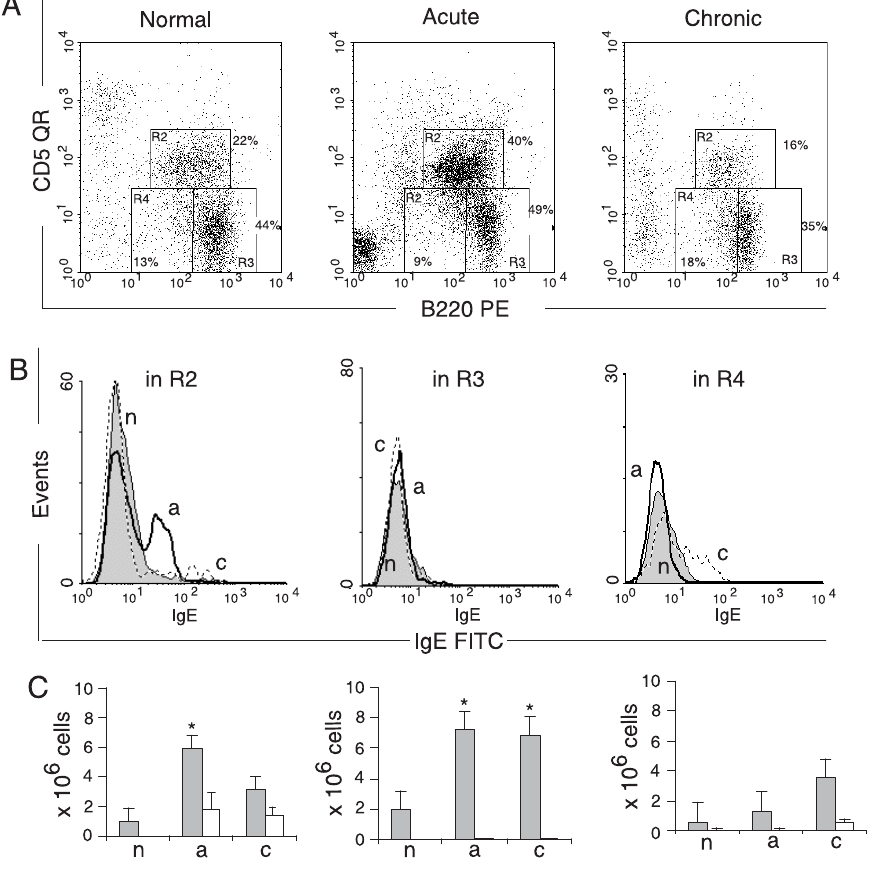
Figure 4 . Surface expression of B220, CD5 and IgE molecules on cells from the peritoneal cav- ity. A , Dot plot of cells in the lymphocyte gate. The R2, R3 and R4 regions represent the B1a, B2 and B1b cells, respec- tively. B , Intensity of IgE on the B-cell surface. C , Total cell num- bers (filled columns) and IgE+ cells (open columns). Data are reported as means ± SEM and are representative of five inde- pendent experiments, each car- ried out in 2 normal mice (n), 5 mice with acute infection (a) and 5 with chronic infection (c). *P < 0.05 for B-IgE + cells compared to total B cells (Tukey multiple comparison